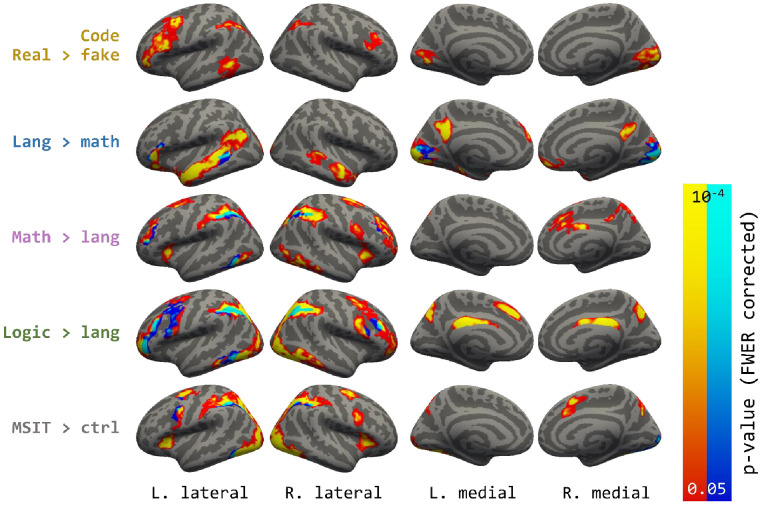
Whole-brain contrasts.Areas shown are p<0.05 cluster-corrected p-values, with intensity (both warm and cold colors) representing uncorrected vertex-wise probability. In the maps for each localizer contrast, both warm and cold colors indicate activated vertices in the contrast, with the cold color labelling the overlap with the code contrast.